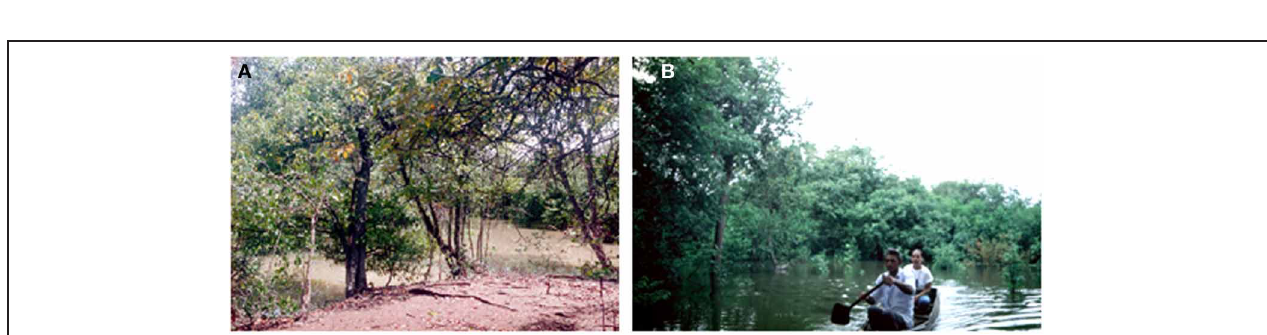
(FW). (B) Schematic view of the vegetation and water level along a gradient from the Mapire bed to the savanna. Approximate location of species indicated. Modified from Fernández et al. (1999) and Herrera et al. (2008b).